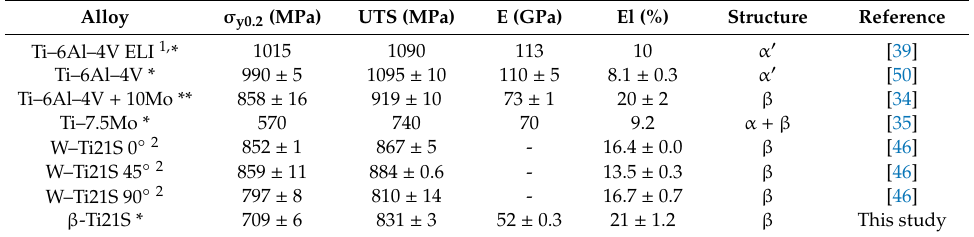
Table 1. Mechanical properties of present β -Ti21S alloy compared with those reported in the literature for additively manufactured and wrought (W) Titanium alloys.